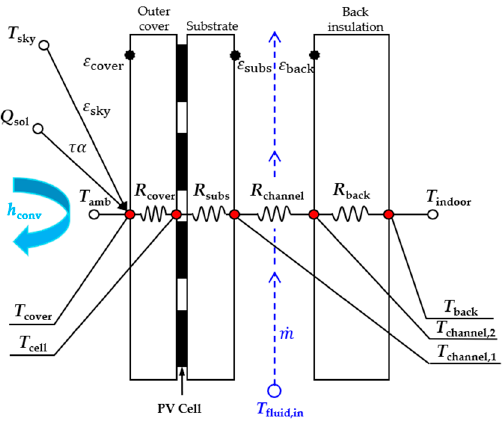
Figure 4. Thermal network of TRNSYS type 567 (BIPV simulation model).